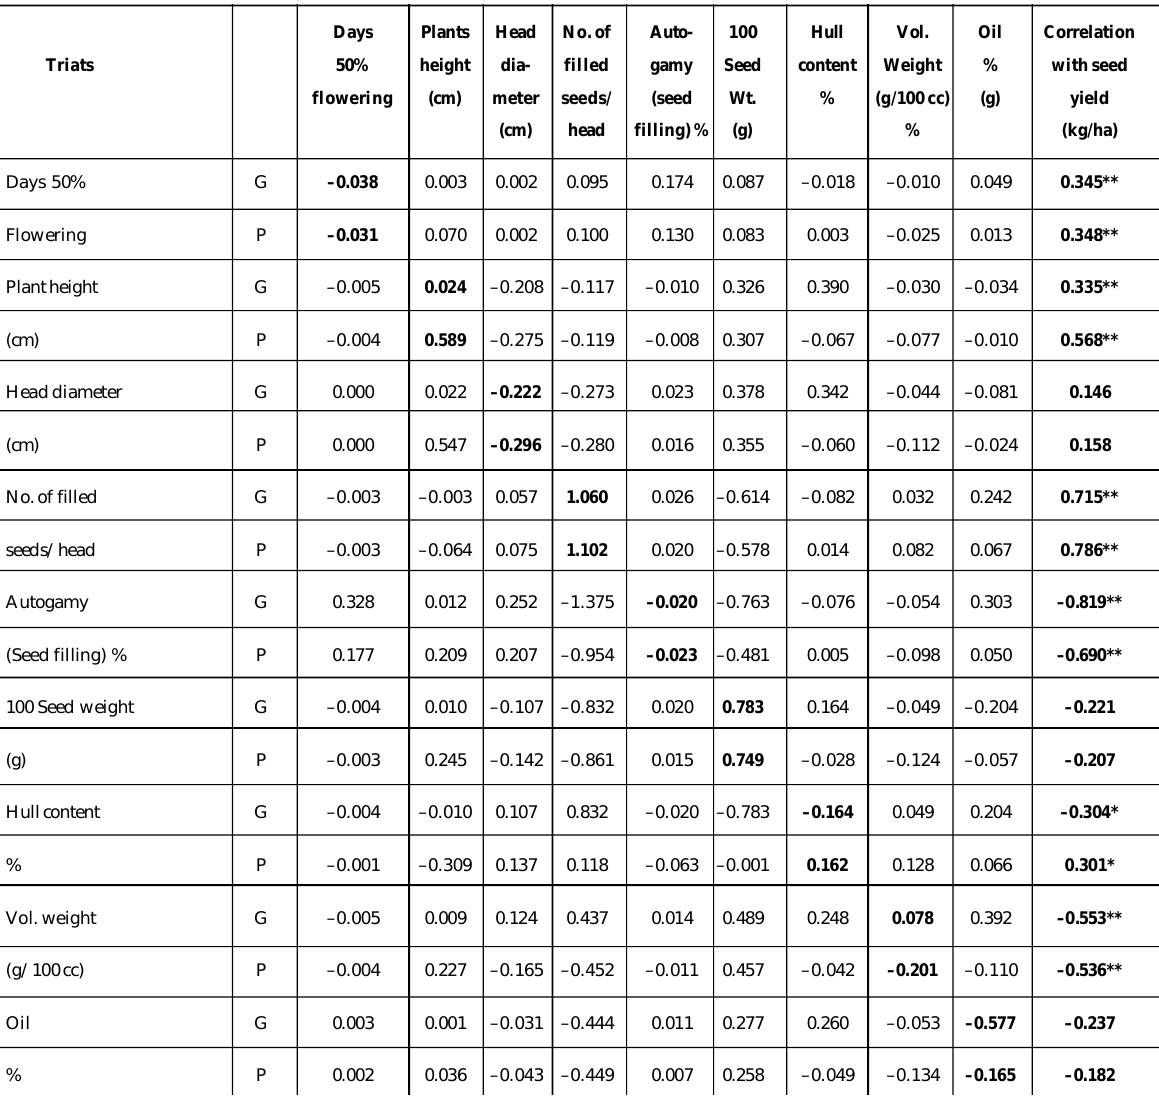
Table 5: Genotypic and phenotypic path coefficients among yield attributing